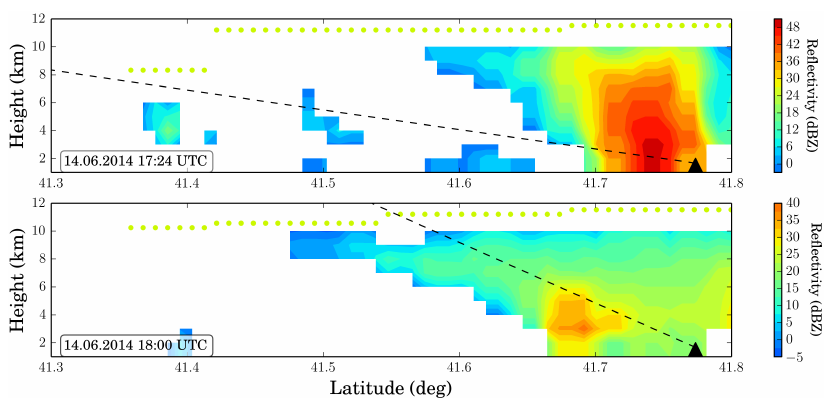
Figure 4. A vertical slice of radar reflectivity (shaded) at two epochs of a rising GNSS occultation event. The dashed black line is the projection of the ray trajectory as simulated with OAT ray tracer on the described plane, and the dots correspond to the cloud top phase (CP) products. In this case, all the green dots indicate ice at the top of the